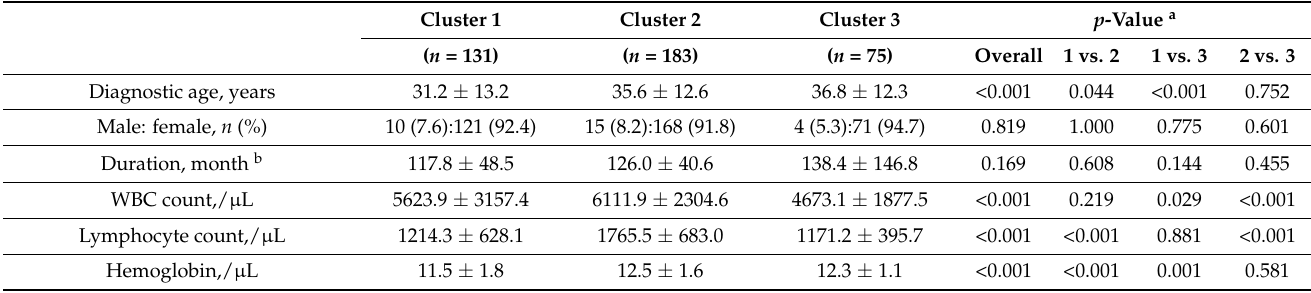
Figure 1. Three subgroups of patients with SLE divided via hierarchically cluster analysis. The patients with SLE ( n = 389) were divided into three clusters based on the laboratory values at the time of SLE diagnosis. ANA, anti-nuclear antibody; C3, complement 3; C4, complement 4; CRP, C-reactive protein; dsDNA, double-stranded DNA; ESR, erythrocyte sedimentation rate; Hb, hemoglobin, lympho, lymphocyte; SLE, systemic lupus erythematosus; WBC, white blood cell. Table 1. Clinical characteristics of the clusters according to the laboratory findings at the time of SLE diagnosis.